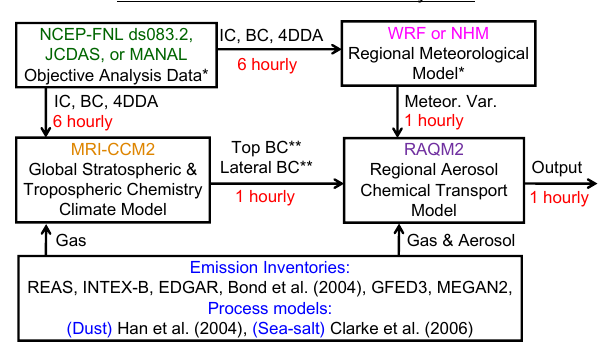
Fig. 1. Framework of Meteorological Research Institute–Passive- tracers Model